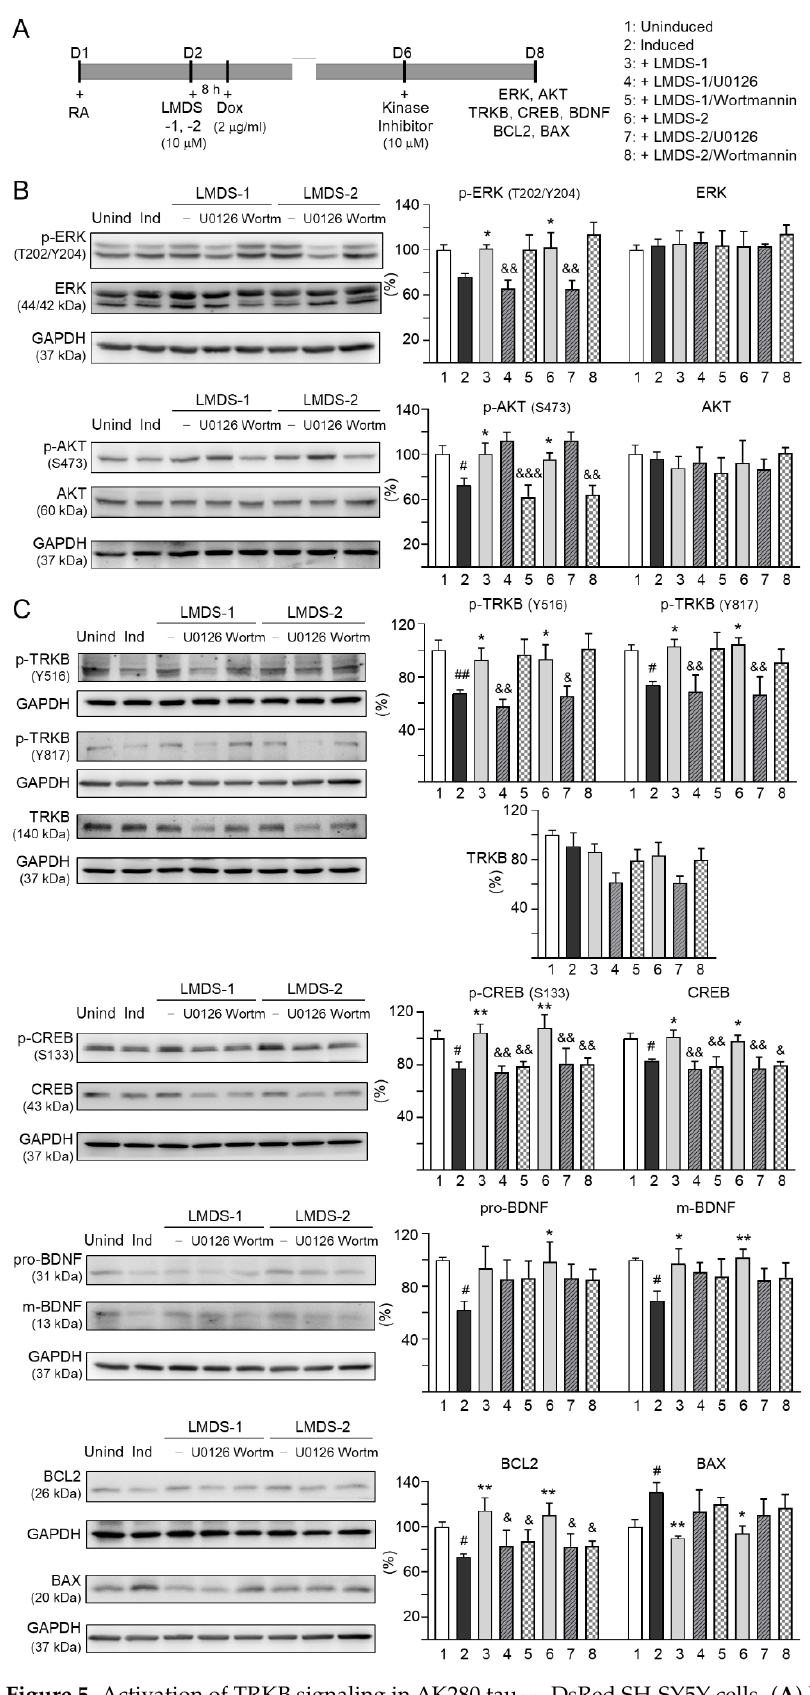
Figure 5. Activation of TRKB signaling in ∆ K280 tau RD -DsRed SH-SY5Y cells. ( A ) Experimental